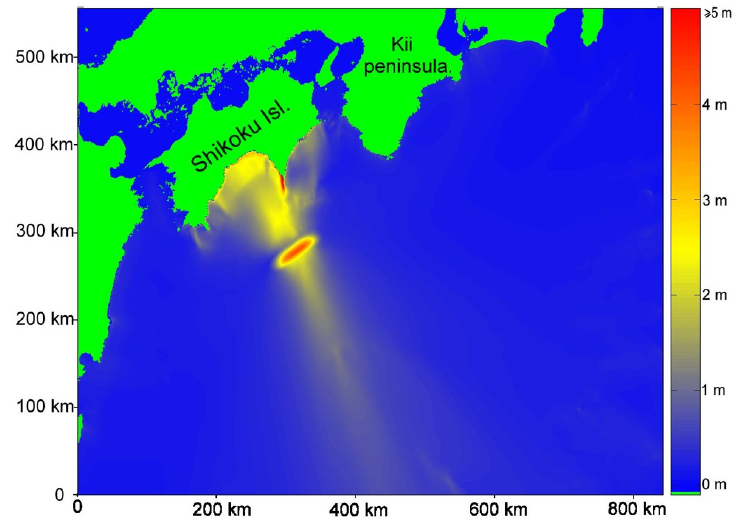
Figure 9. Distribution of wave height maxima as the result of a tsunami wave generated by source S1-a (see Figure 3). (see Figure